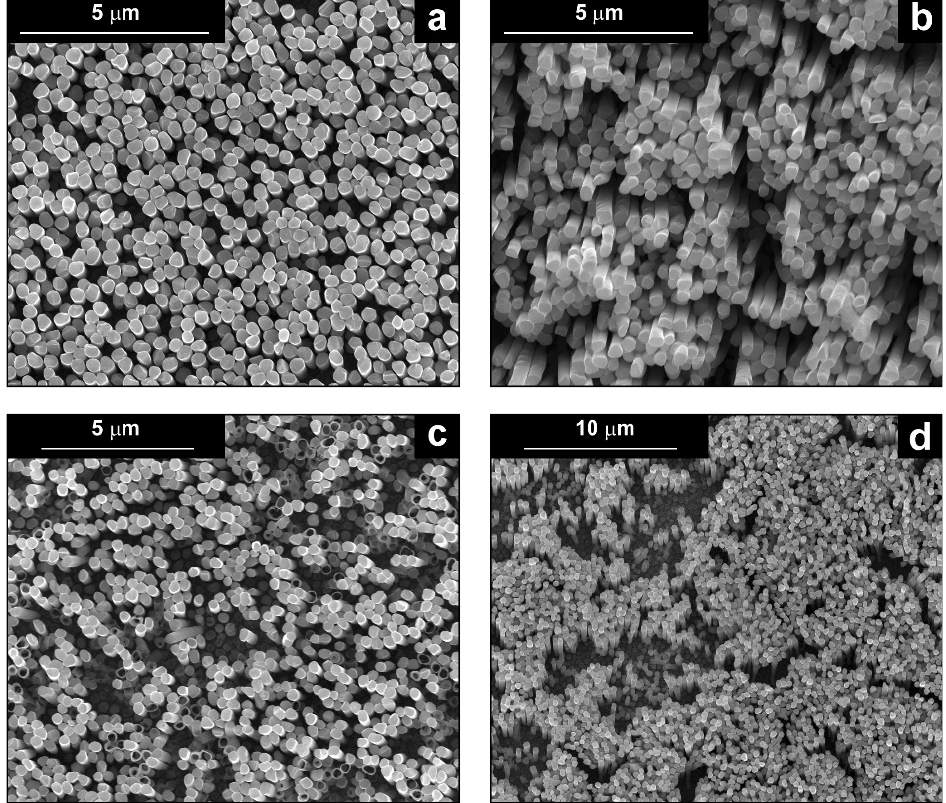
Figure 3. FESEM images of the Pd–Co alloy: ( a , b ) as prepared ( a ) top view, (( b ) tilted top view), ( c , d ) after CV in 2 M H 2 SO 4 ( c ) top view, (( d ) tilted top view).